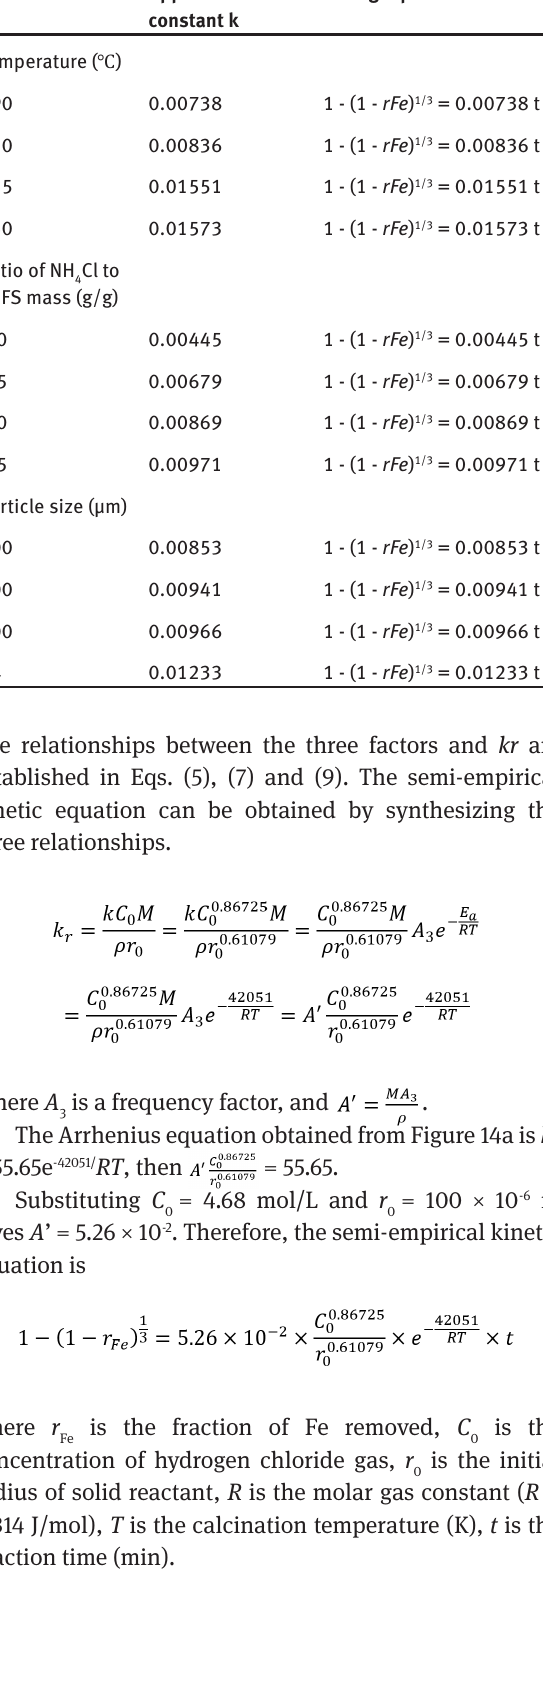
) 1/3 vs time for all experimental data. Table 6: Parameters of 1 − (1 − r Fe Apparent